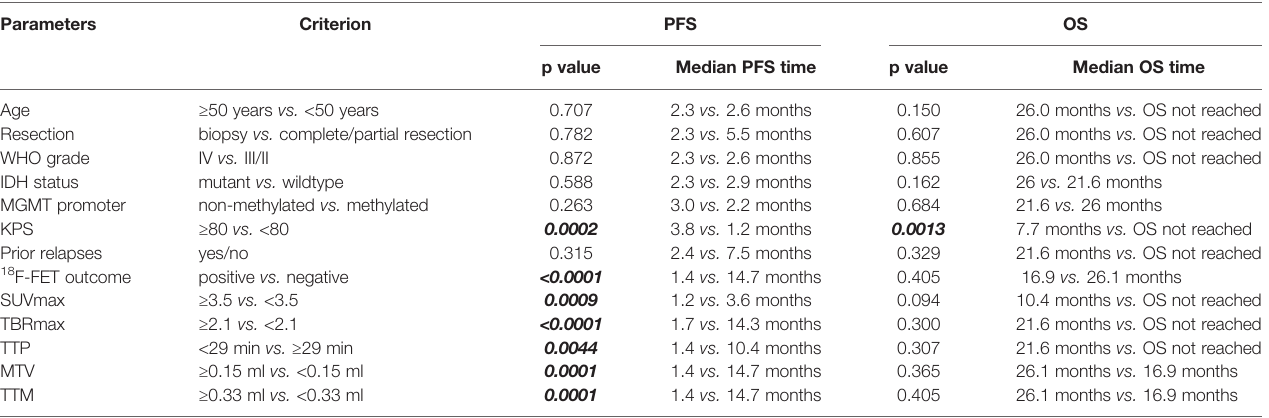
TABLE 4 | Univariate analysis. Parameters